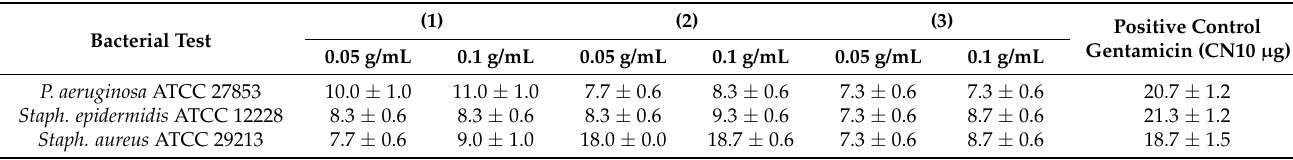
Table 2. Antibacterial activity of the three derivatives, at different concentrations using paper disk diffusion method, zone of inhibition (mm) means ± SD *. Bacterial